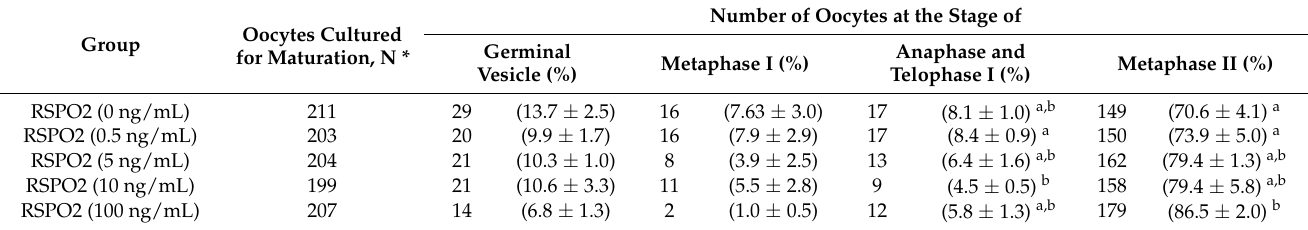
Table 3. Effect of R-spondin2 (RSPO2) treatment during in vitro maturation (IVM) on nuclear maturation. Number of Oocytes at the Stage of Oocytes Cultured Group Germinal for Maturation, N * Metaphase I (%) Vesicle (%)